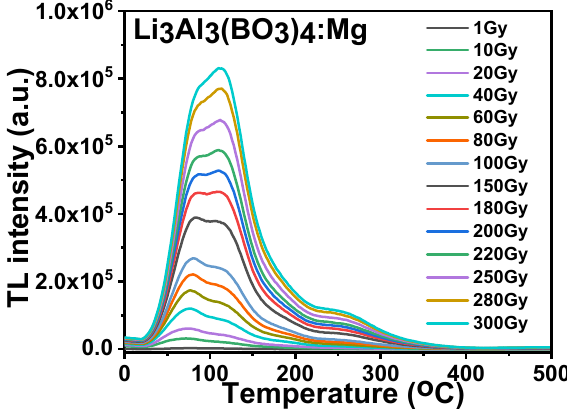
Figure 13. The dose–response of Mg ‐ doped lithium aluminium borate.